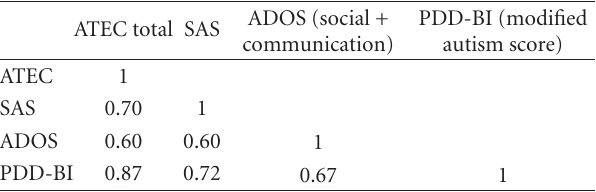
Table 3: Correlation of autism severity